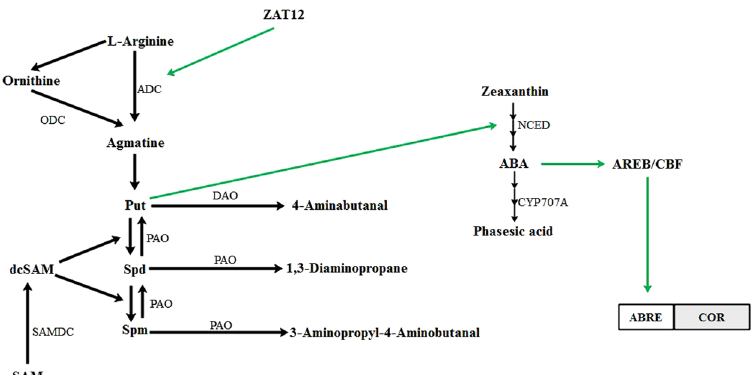
Figure 10. Metabolism of polyamines and abscisic acid (ABA) in plants. Put putrescine, Spd spermidine, Spm spermine, SAM S-adenosylmethionine, dcSAM decarboxylated S-adenosylmethionine, ADC, Arginine decarboxylase, ODC ornithine decarboxylase, SAMDC S-adenosylmethionine decarboxylase, DAO Diamine oxidase, PAO polyamine